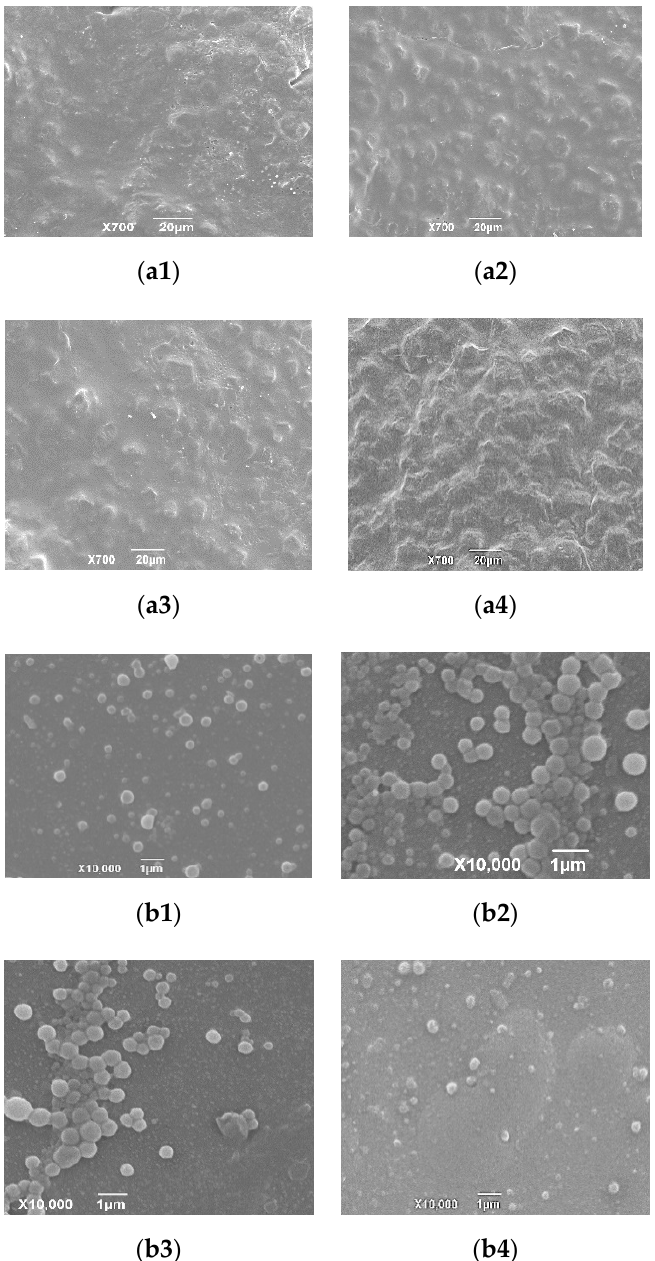
Figure 7. SEM imaging of enteric coating membrane ( a1 – a4 ) and inner TIL-SLNs ( b1 – b4 ) under influence factors experiments. The surface coating membrane and inner TIL-SLNs could keep intact under influence factors experiments. Note: ( a1 ): day 0; ( a2 ): 10th day under high temperature; ( a3 ): 10th day under high humidity; ( a4 ): 10th day under high light; ( b1 ): day 0; ( b2 ): 10th day under high temperature; ( b3 ): 10th day under high humidity; ( b4 ) 10th day under high light. To verify the